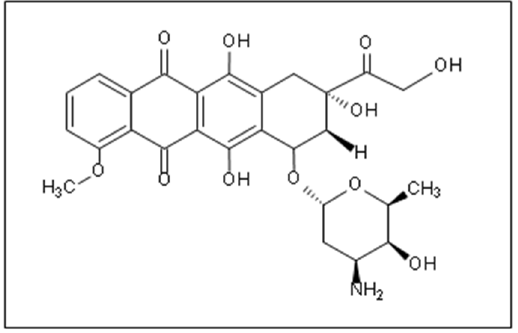
Figure 1. The chemical structure of DOX